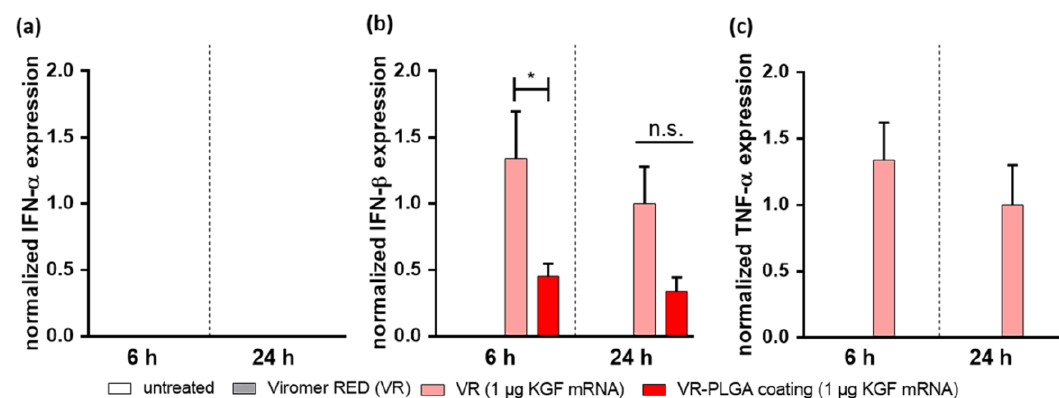
Figure 5. Analyses of di ff erent proinflammatory genes in BJ fibroblasts after transfection with therapeutic mRNA-complexes or mRNA-coated sutures. qRT-PCR was used to determine the release of interferon alpha ( a ), interferon beta ( b ), and tumor necrosis factor alpha ( c ) 6 h and 24 h post transfection. The expression pattern of untreated cells was compared to the one of cells treated with Viromer RED only, cells transfected with 1 µ g KGF mRNA in a direct manner, or transfected via the mRNA-PLGA coating containing 1 µ g KGF mRNA. ( n = 4; * p < 0.05, n.s. = not